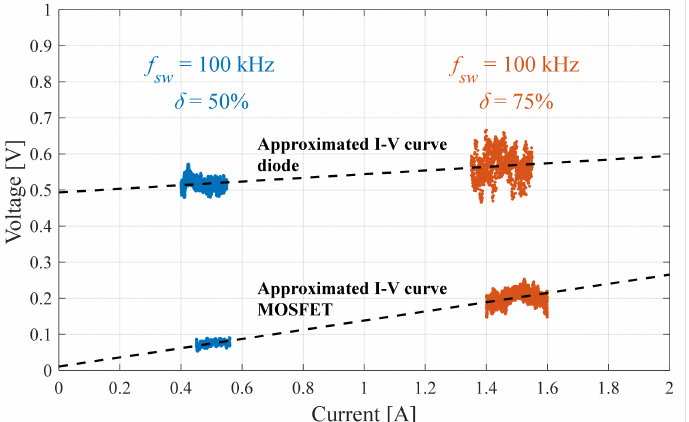
Figure 10. Estimation of the MOSFET and diode approximated on state v-i curves.